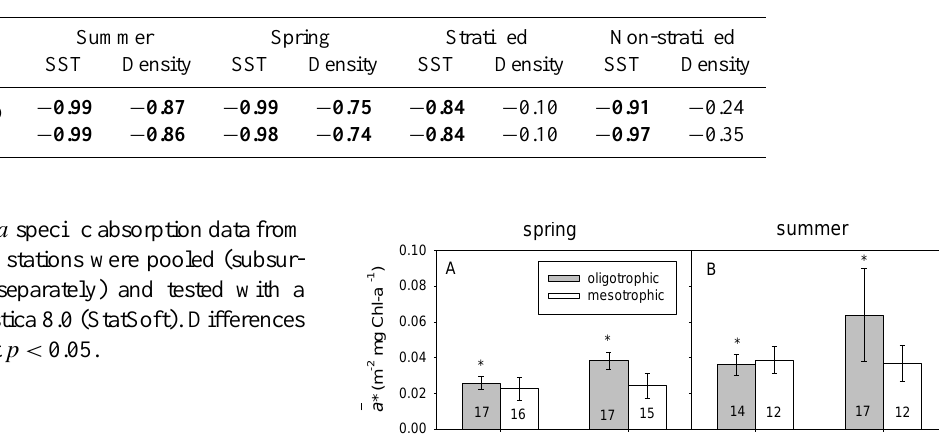
Chl-a max Fig. 3. The spectrally weighted mean specific absorption coefficient ( ¯ a ∗ ) for the chlorophyll maximum (Chl a max) and subsurface sam- ples for oligotrophic and mesotrophic stations, obtained during the spring (A) and summer (B) cruises (average ± standard deviation). The number of replicates is indicated in the bars. Significant differ- ences between chlorophyll maximum and subsurface samples are indicated with ∗